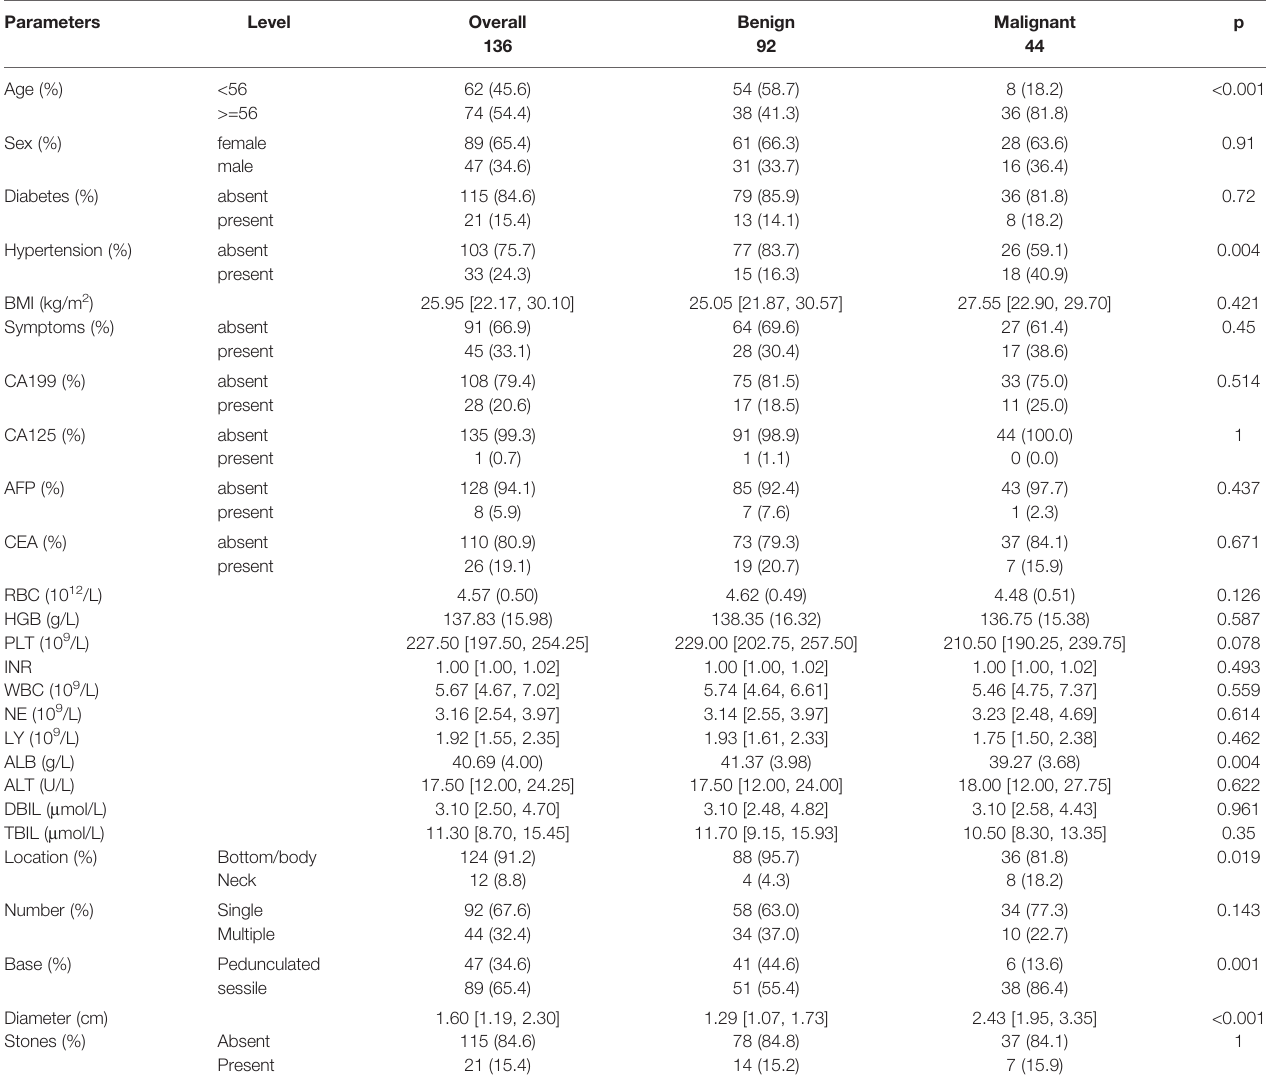
TABLE 1 | Demographics and clinical characteristics.